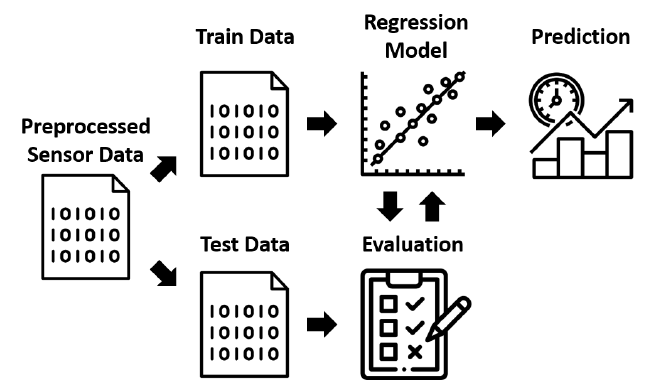
Figure 3. Regression Model